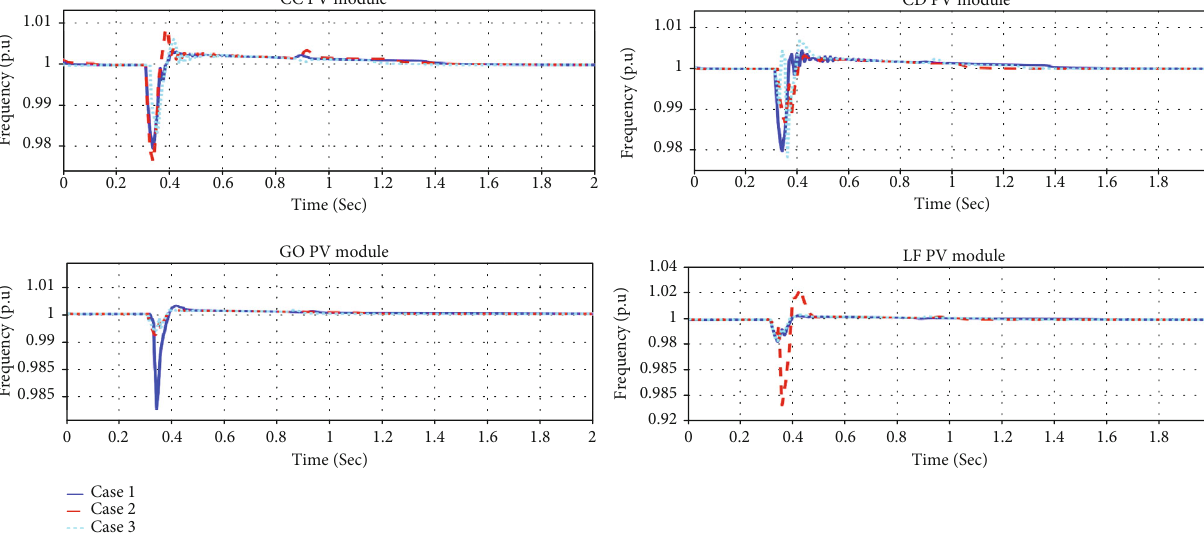
Figure 11: Frequency for PV module according to the four dispatch strategies. This fi gure is reproduced from Shezan et al.